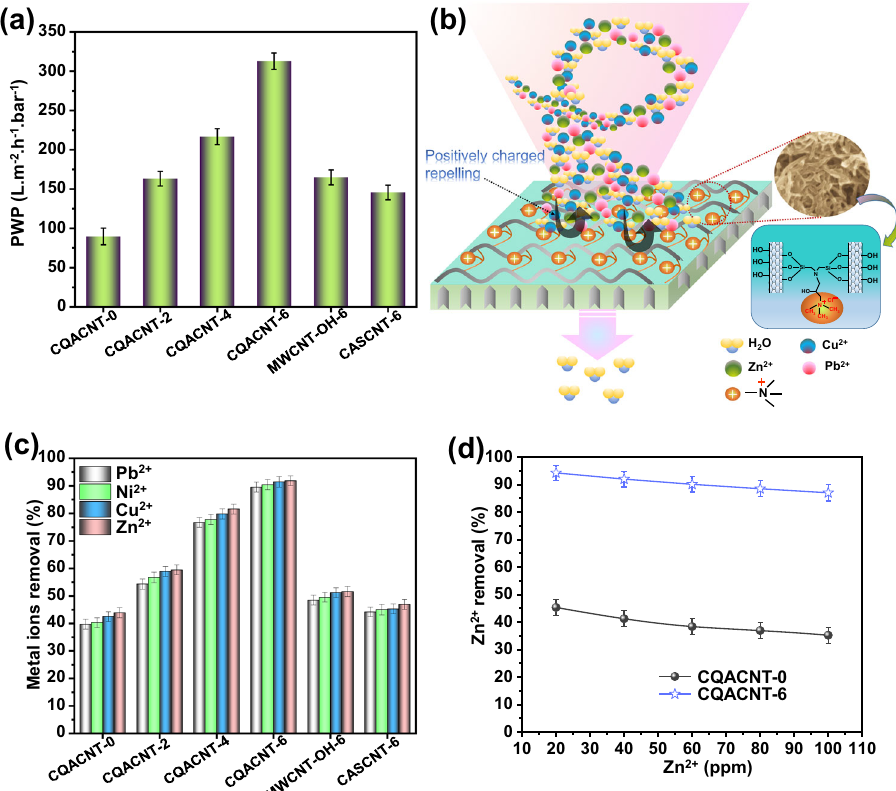
Fig. 8 Comparative performance studies of fabricated membranes. a Pure water permeability; b Representation of electrostatic repulsion mechanism between the surface of CQACNT composite membrane and metal ions; c Metal ion removal performance of the prepared membranes; d Effect of Zn 2 + concentration on the removal ef fi ciency of CQACNT-0 and CQACNT-6 membranes. Error bars represent the standard deviation between three reported